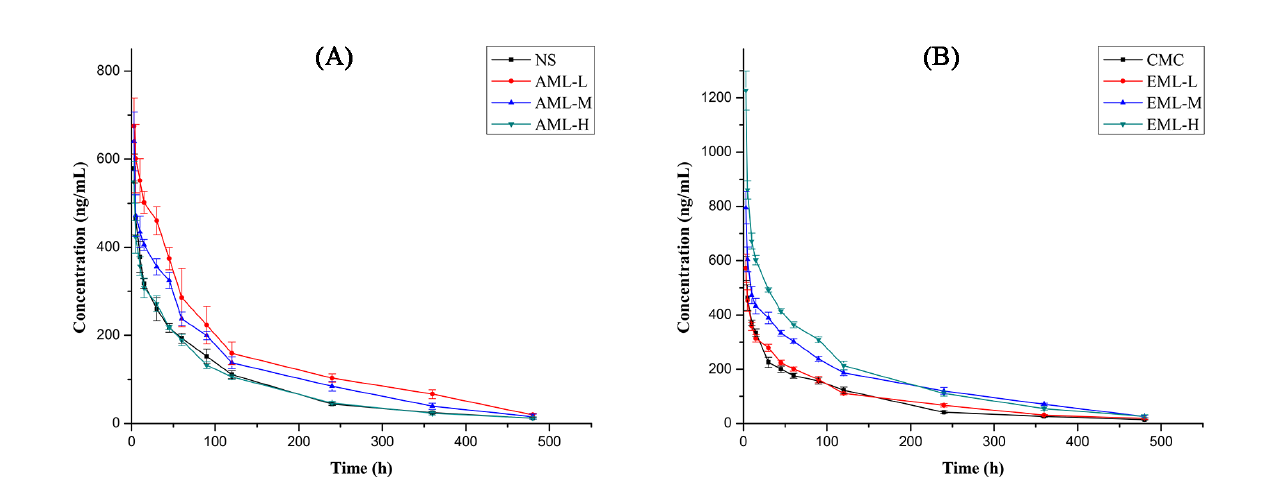
FIGURE 4 – Mean plasma concentration-time profiles of dextromethorphan in rats pre-treated with AML (A) and EML